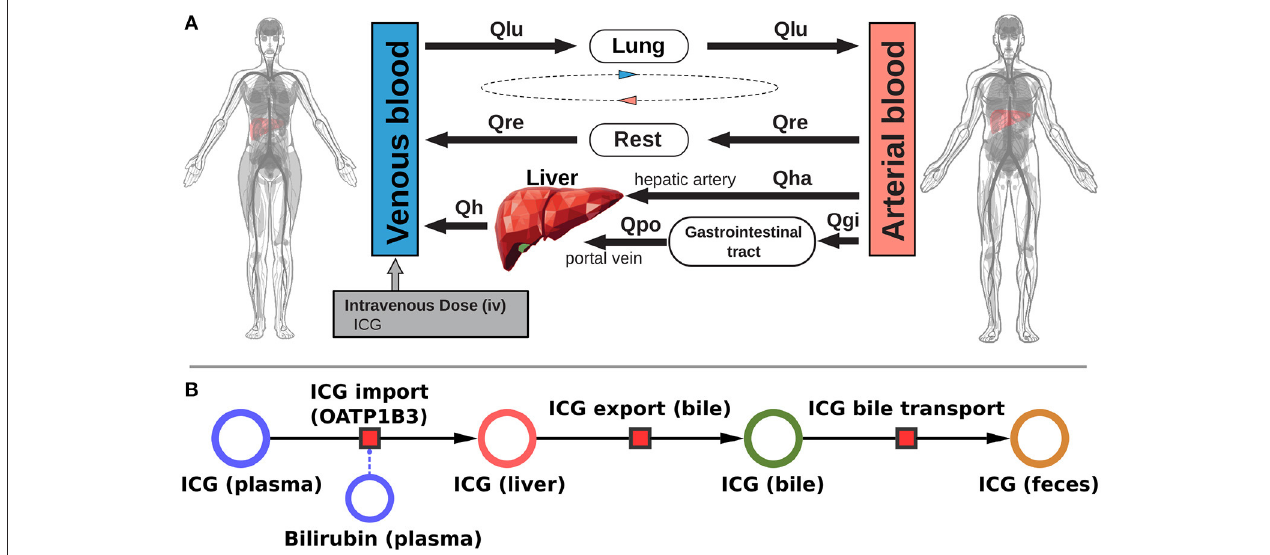
FIGURE 1 | Model overview: (A) PBPK model. The whole-body model for ICG consists of venous blood, arterial blood, lung, liver, gastrointestinal tract, and rest compartment (accounting for organs not modeled in detail). The systemic blood circulation connects these compartments. (B) Liver model. ICG is taken up into the liver tissue (hepatocytes) via OATP1B3. The transport was modeled as competitively inhibited by plasma bilirubin. Hepatic ICG is excreted in the bile from where it is subsequently excreted in the feces. No metabolism of ICG occurs in the liver. Figure adapted from Köller et al. (2021).